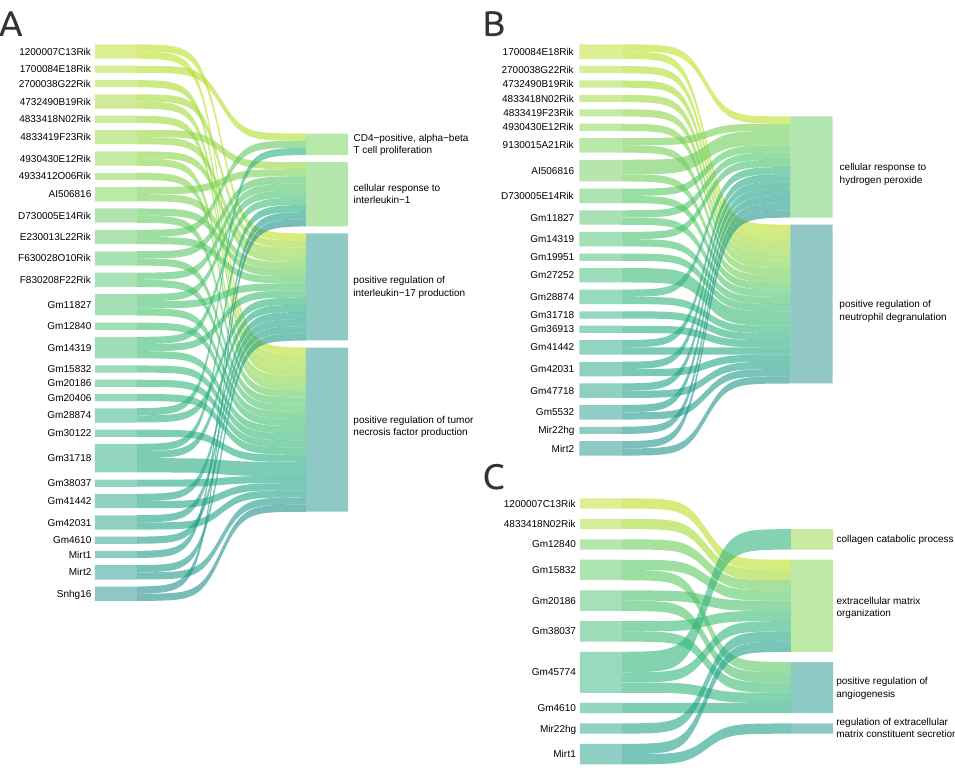
Figure 7. Sankey plot representing the GO terms inferred to the selected lncRNAs. The GO terms were grouped according to its biological function. ( A ) GO terms associated with the inflammatory response. ( B ) GO terms associated with reactive oxygen species.( C ) GO terms involved in response to